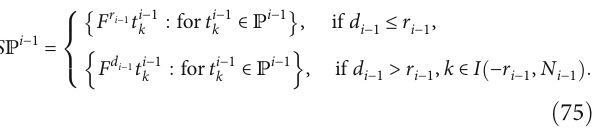
Figure 9: The graph of interaction coe ffi cients κ and κ